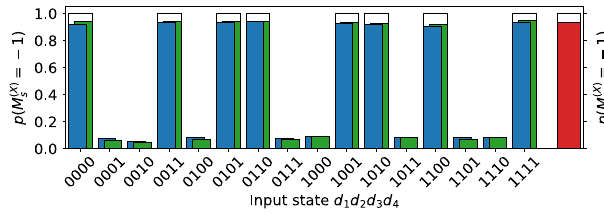
FIG. 4. Fault-tolerant parity readout. The syndrome M ð X Þ s ¼ − 1 event rate is shown for each computational basis input state of the data qubits for all valid shots (blue) and postselected on the flag qubit (green), versus ideal rate (white). 960 shots per input state are measured; the average shot-noise error per input state is about FIG. 6. Fault-tolerant parity readout including an injected error 7 × 10 − 3 . The flag M ð X Þ ¼ − 1 readout rate is shown separated at between gates d 2 s and d 3 s . The syndrome M ð X Þ s ¼ − 1 event rate is f shown versus the logical input state of the data qubits. 140 shots the right (red). per input state are measured, the average shot-noise error per input state is about 2 . 5 × 10 − 2 . (a) pertains to a Y -type error, which does not affect the syndrome readout. (b) pertains to an X -type error, which also flips the logical result of the syndrome. In both cases, the flag qubit is detected predominantly in M ð X Þ sponding to detection of the